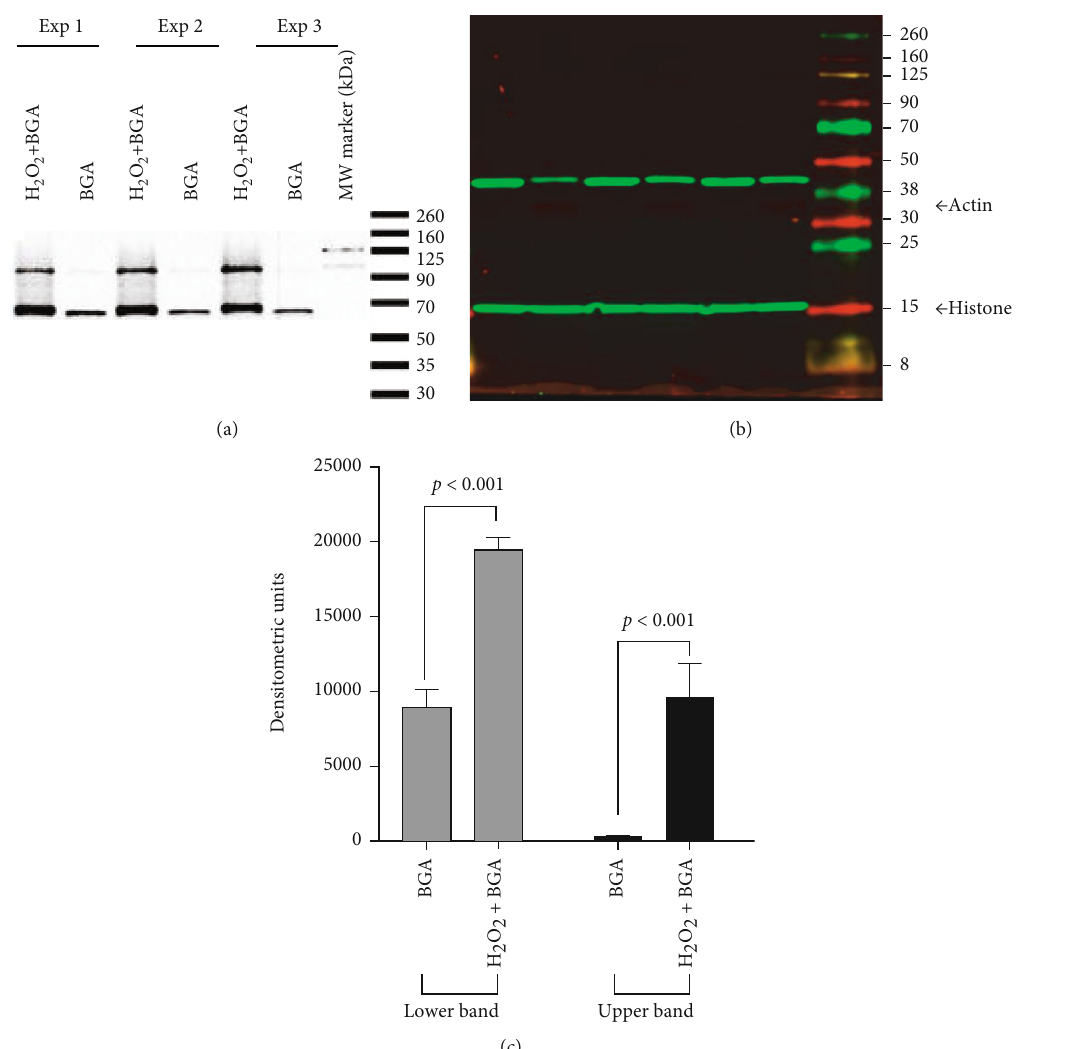
Figure 6: Nuclear localization of biotinylated glucaric acid (BGA) in necrotic H9c2 cells. (a) Streptavidin-HRP blot of nuclear fraction. (b) Immunoblots of histone (15 kDa) and actin (43 kDa). (c) Densitometry (DM; n = 3 ) of two streptavidin-reactive bands.